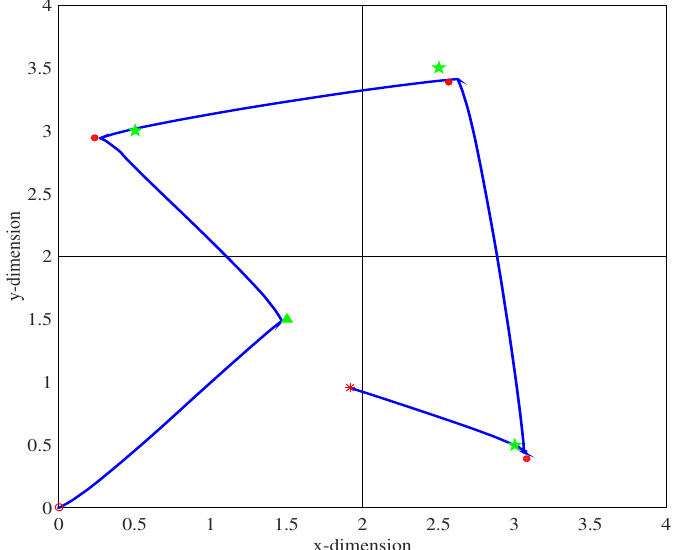
Figure 7. The robot movement trajectory in the real environment with 3 signal sources and 0 obstacles.